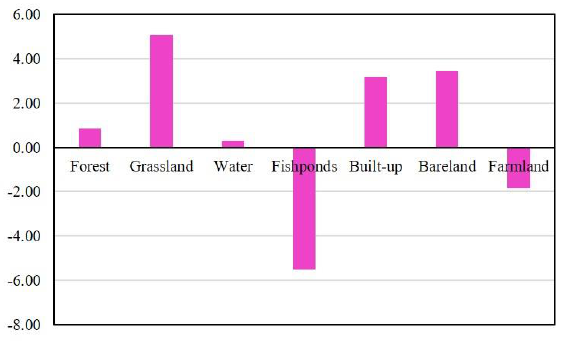
Figure 4. Annual rate of change (2010 — 2017)